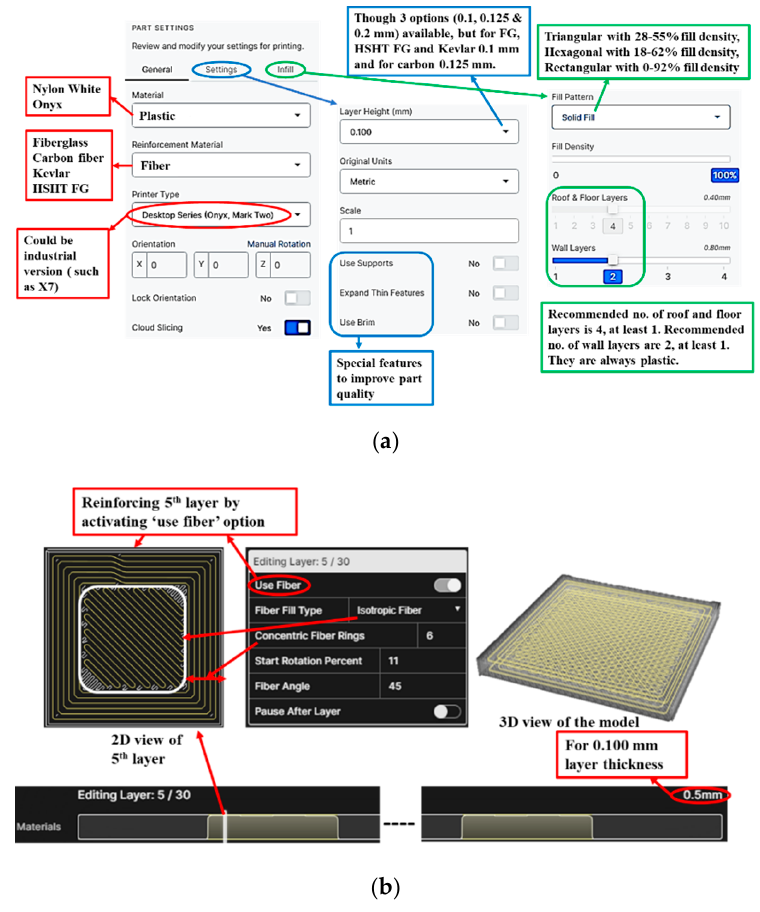
Figure 5. Interfaces of Eiger software for parameter setting and slicing: part view for parameter settings ( a ) and internal view for slicing as well as exploring different options for fiber-reinforcement ( b ).